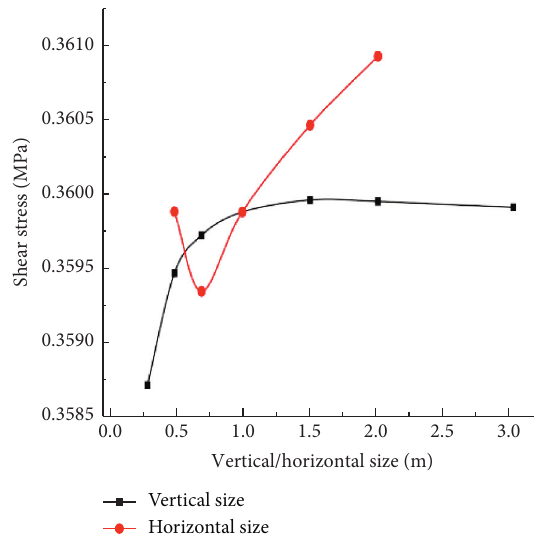
Figure 23: The effect of horizontal/vertical size on shear stress of leveling layer.